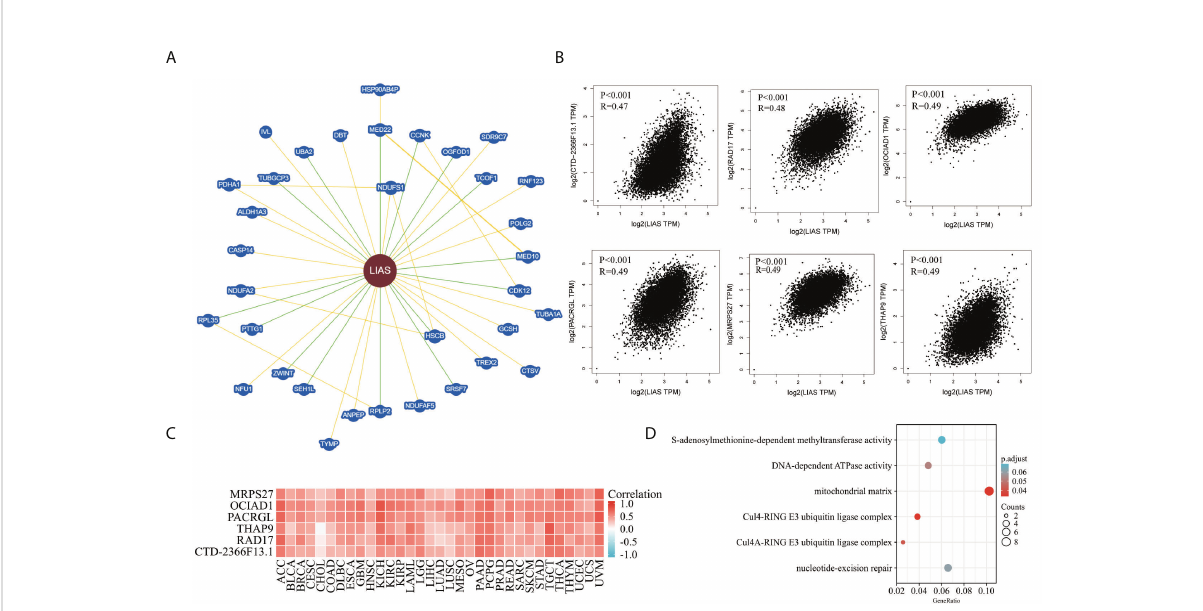
FIGURE 9 The functional enrichment analysis of LIAS-related genes across TCGA cancers. (A) The BioGRID database implicated the interactive network of LIAS-associated biomarkers. (B) GEPIA2.0 revealed that LIAS expression had a positive relationship with six genes (CTD-2366F13.1, RAD17, OCIAD1, PACRGL, MRPS27, and THAP9). (C) The heatmap revealed the positive correlation between LIAS expression and six genes (CTD- 2366F13.1, RAD17, OCIAD1, PACRGL, MRPS27, and THAP9). (D) The G0/KEGG analysis of LIAS-related